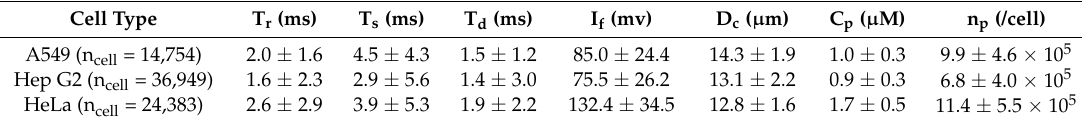
Table 1. A summary of quantified key parameters of A549, Hep G2 and HeLa cells including T r (time duration of the rising domain for a fluorescent pulse representing a traveling cell), T s (time duration of the stable domain for a fluorescent pulse representing a traveling cell), T d (time duration of the declining domain for a fluorescent pulse representing a traveling cell), I f (fluorescent level of the stable domain for a fluorescent pulse representing a traveling cell), D c (diameter of cells), C p (concentration of β -actins at the single-cell level) and n p (absolute copy number of β -actin proteins at the single-cell